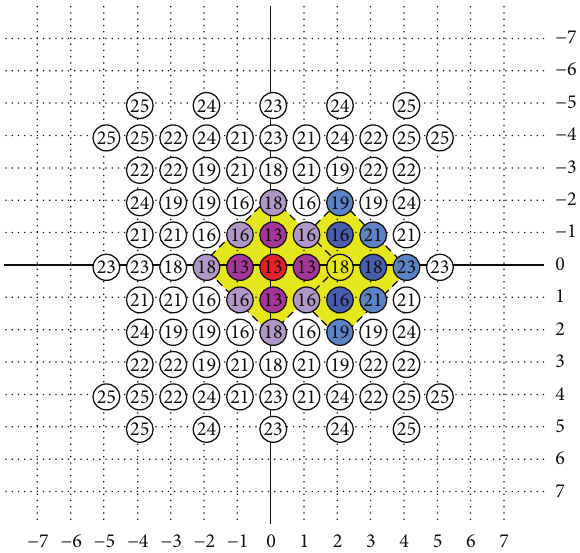
Figure 8: Minimum possible number of search points within the search window with HEXBS.